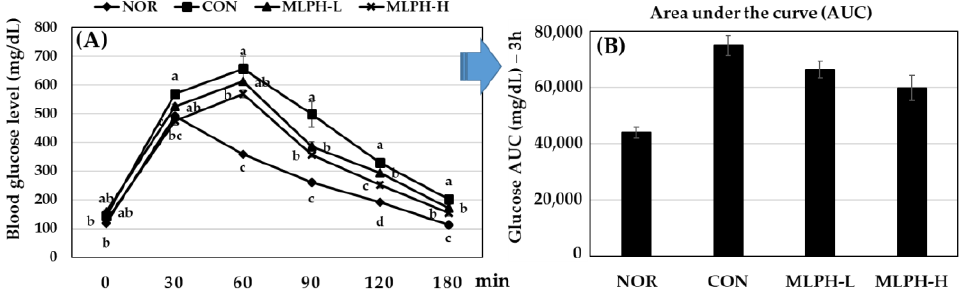
Figure 3. ( A ) Glucose tolerance test and ( B ) area under the curve results for mice treated with MLPH fractions for 6 weeks and fasted for 14 h before intraperitoneal injection of glucose (2 g/kg body weight). After glucose injection, blood samples were collected from the tail vein at 0, 30, 60, 90, 120, and 180 min. Each value represents the mean ± SEM ( n = 6). a–c Values not sharing a common letter are significantly different at p < 0.05 by Tukey’s multiple comparison test.